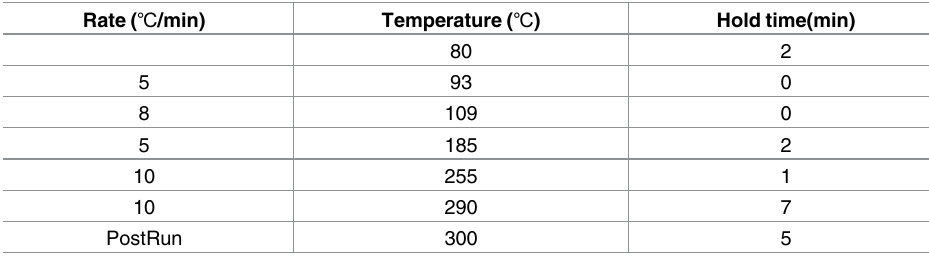
Table 1. Programmed temperature of